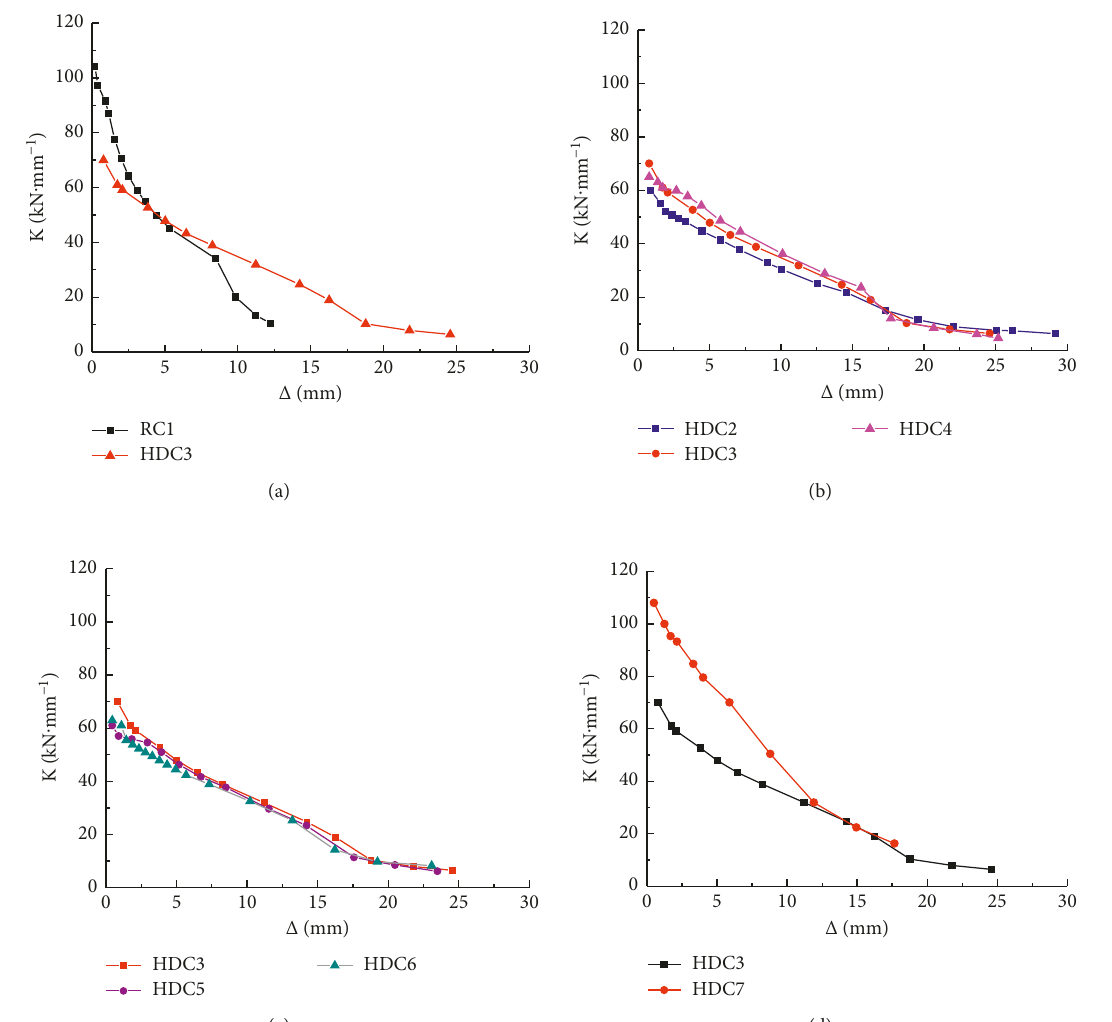
Figure 10: Curves of stiffness degradation: (a) effect of the material, (b) effect of the axial load ratio, (c) effect of the stirrup ratio, and (d) effect of the shear span ratio.